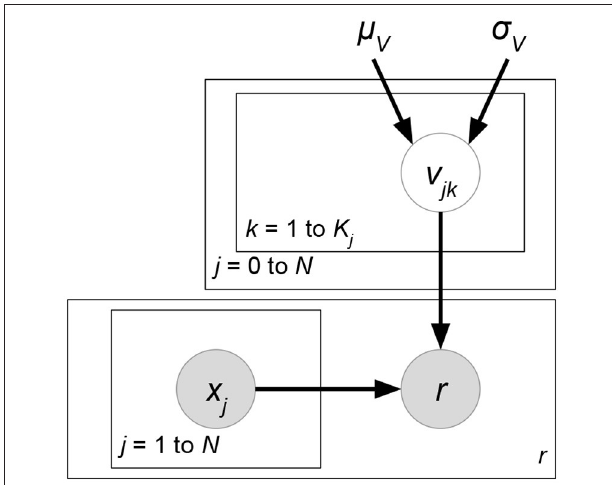
where δ ( R ) indicates the set of observed ratings in training data.